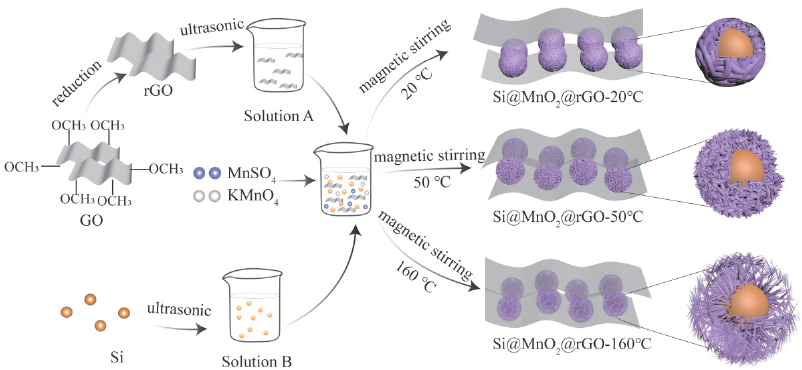
Figure 1. Concise preparation schematics of the Si@MnO 2 @ reduced graphene oxide (rGO) composites.